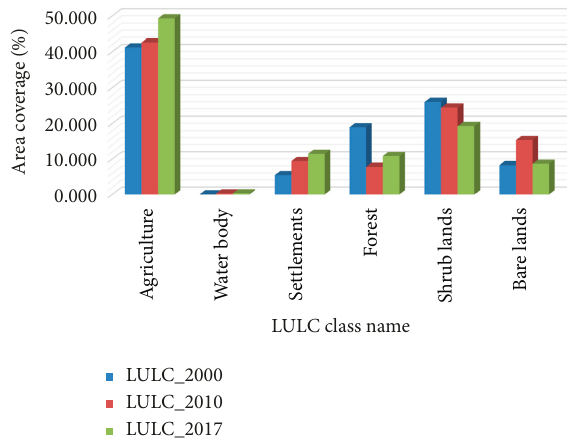
Figure 5: Land use/land cover distributions and changes of 2000, 2010, and